Question: Briefly state, in one sentence, what is plotted here.
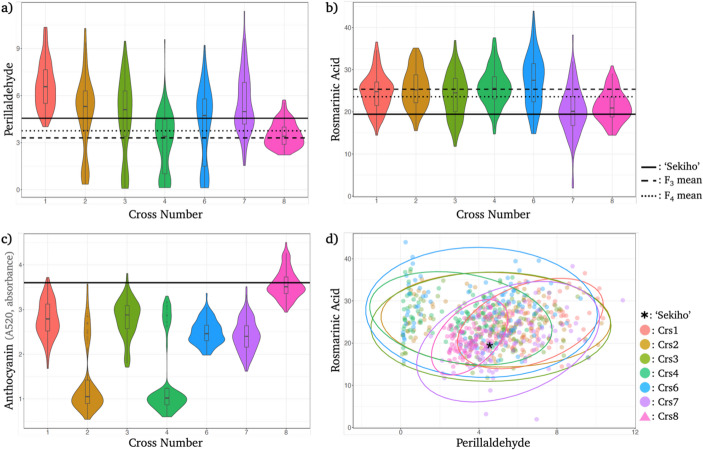
Answer: Observed phenotypes of G₂ progeny derived from each cross. Colors indicate different cross pairs. Panels ( a )–( c ) show violin plots of G₂ phenotypes for perillaldehyde, rosmarinic acid, and anthocyanin, respectively. In panels ( a ) and ( b ), solid lines represent the phenotypic values of the cultivar ‘Sekiho’ measured in the same field and in the same year as the G₂ generation, dashed lines indicate the mean phenotypic values of the F₃ generation, and dotted lines indicate the mean values of the F₄ generation. In panel ( c ), the solid line represents the anthocyanin value of ‘Sekiho’ measured in the same field, in the same year, and using the same protocol as the G₂ generation. Panel ( d ) shows a scatter plot of perillaldehyde and rosmarinic acid phenotypes in the G₂ generation. Ellipses represent the 95% confidence intervals of the two traits for each cross pair, and black crosses indicate the phenotypic values of the cultivar ‘Sekiho’ grown in the same year